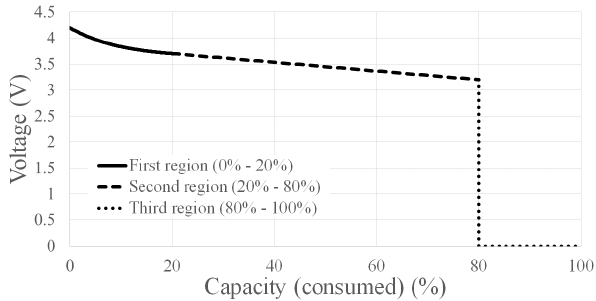
Figure 9. Single-cell LiPo battery discharge model.